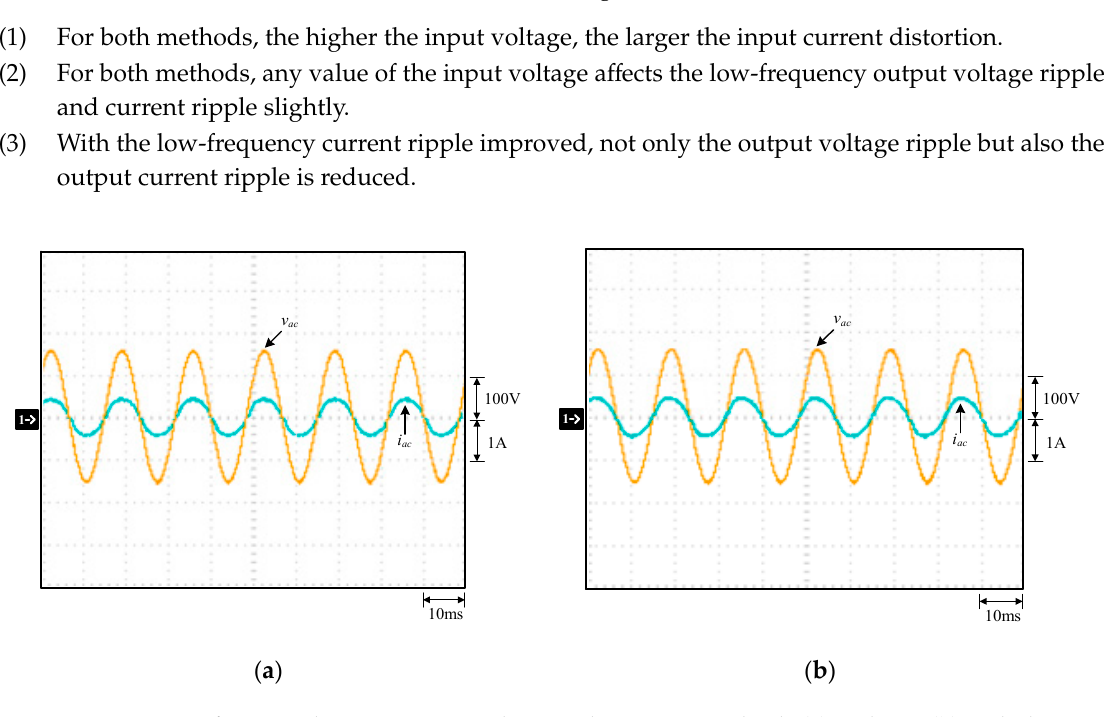
Figure 7. Waveforms under 110 V input voltage and 100% output load: ( a ) without; ( b ) with the proposed low-frequency current ripple improved: (1) v ac ; (2) i ac .